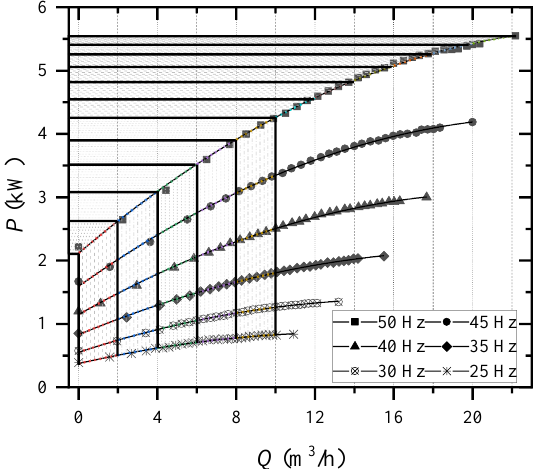
Figure 7. Power variation of QP curve. The input frequencies of 50 Hz, 45 Hz, 40 Hz, 35 Hz, and 30 Hz are fitted to the curves with flow rates of Q 0 = 0 m 3 /h, Q 1 = 3 m 3 /h, Q 2 = 6 m 3 /h, Q 3 = 9 m 3 /h, Q 4 = 15 m 3 /h, and Q 5 = 21 m 3 /h. The fitted equations are shown in Equations (6) – (11).